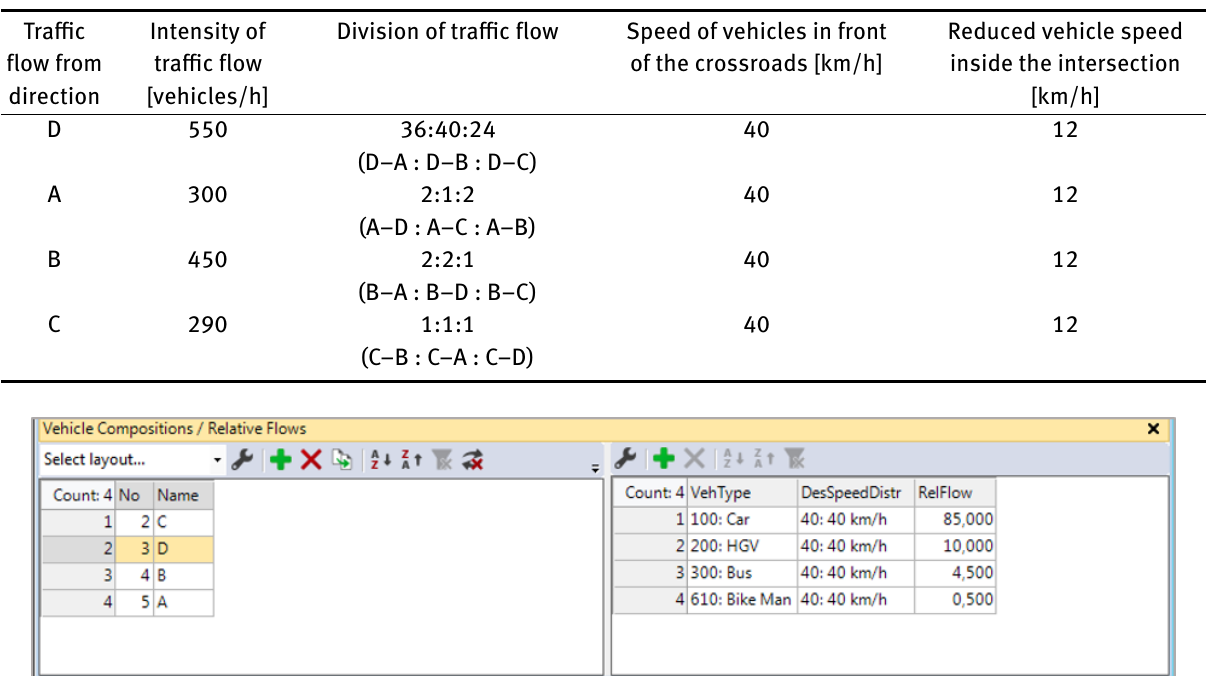
Table 5: Traflc flow parameters